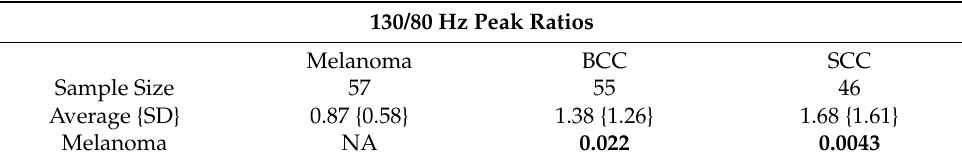
Values in bold represent statistically significant p